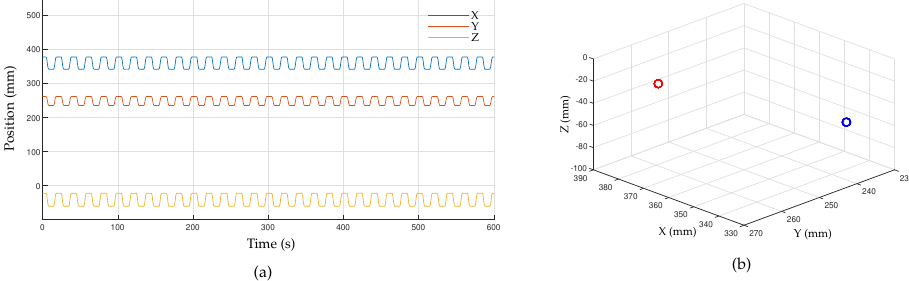
Figure 13. Experimental results on positional accuracy: ( a ) measured end-effector position from the developed motion-tracking system; ( b ) sampled points at the origin (red) and the target (blue).